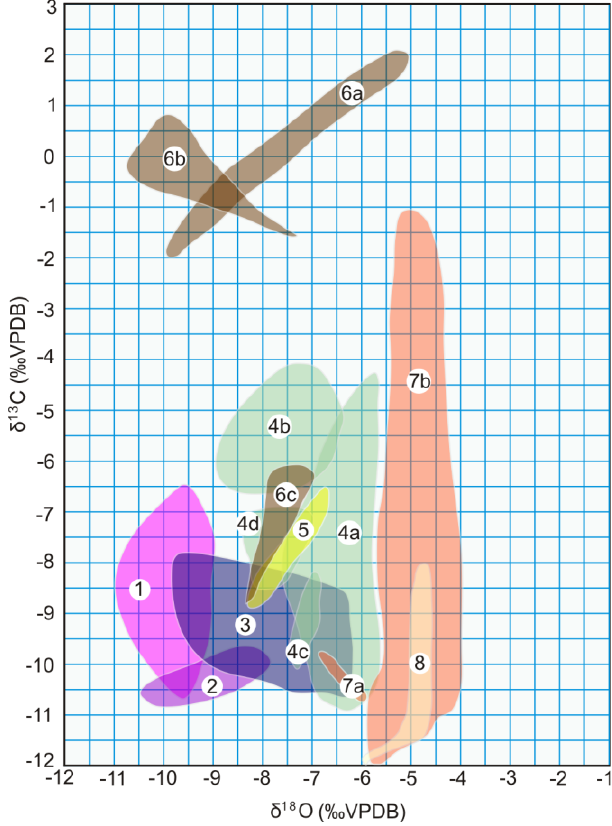
Figure 6. Comparison of stable isotope data in this study with other deposits in Europe. 1. Serbia,